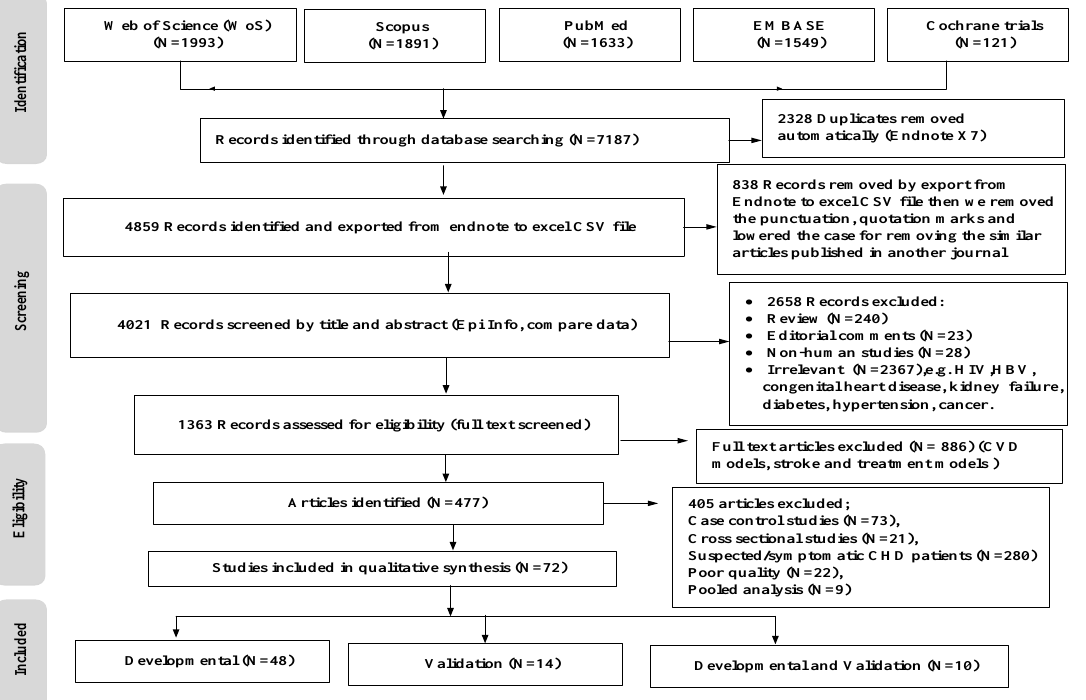
Figure 1. Flow chart of the selection process of coronary heart disease risk prognostic models.